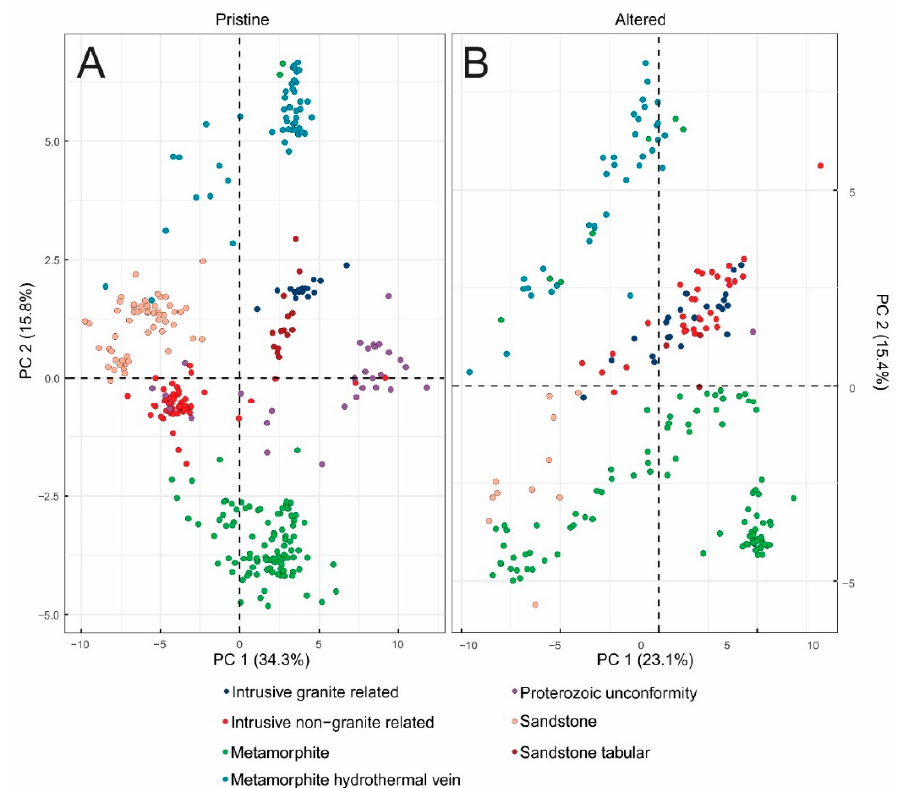
Figure 7. Principal component analysis for ( A ) pristine and ( B ) altered uraninite samples using all variables; pristine and altered both use major (wt. %; Table S1), minor and trace (ppm; Table S2) abundances and Sr, Pb, and U isotopic compositions (Table S4). The altered PCA also uses the secondary minerals that were identified with PXRD (Table S3). Two principal component analyses were conducted; therefore, the PC 1 and PC 2 are different vectors for both the pristine and altered PCA.